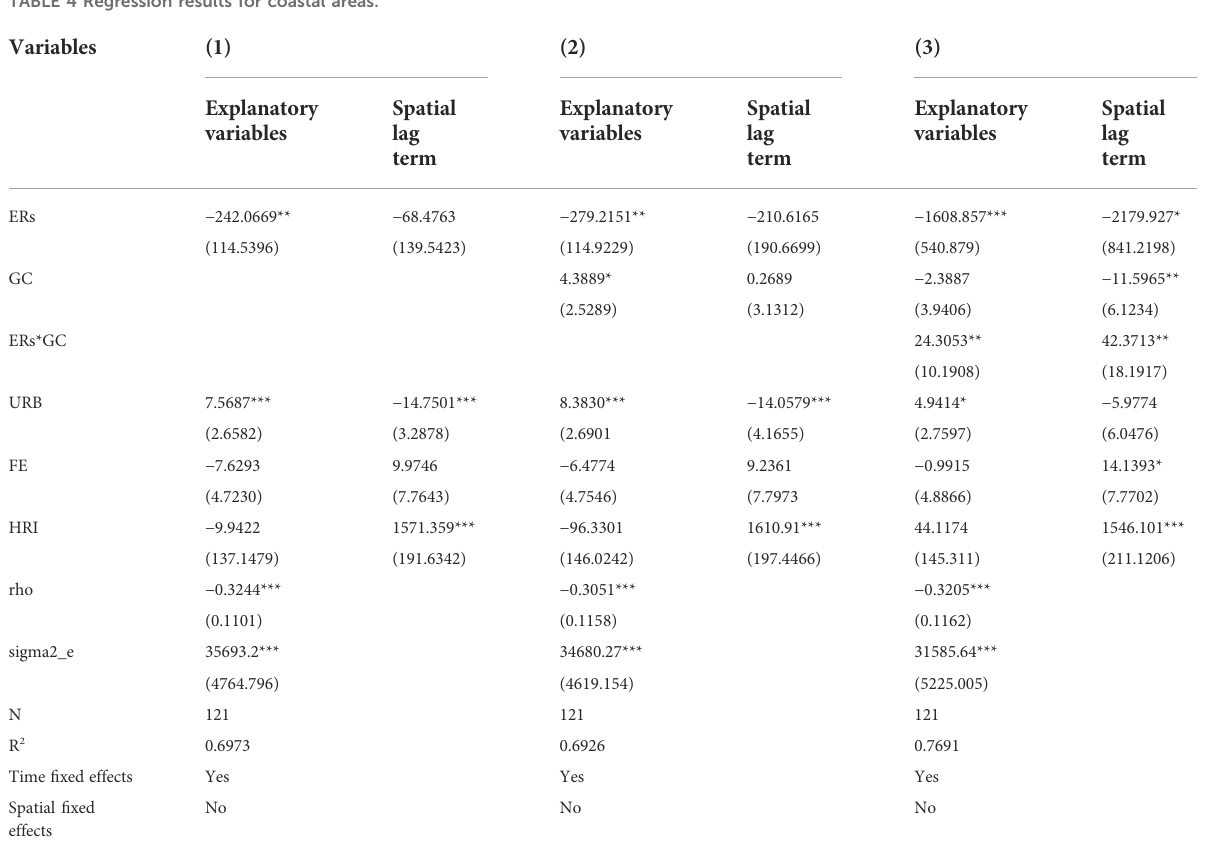
TABLE 4 Regression results for coastal